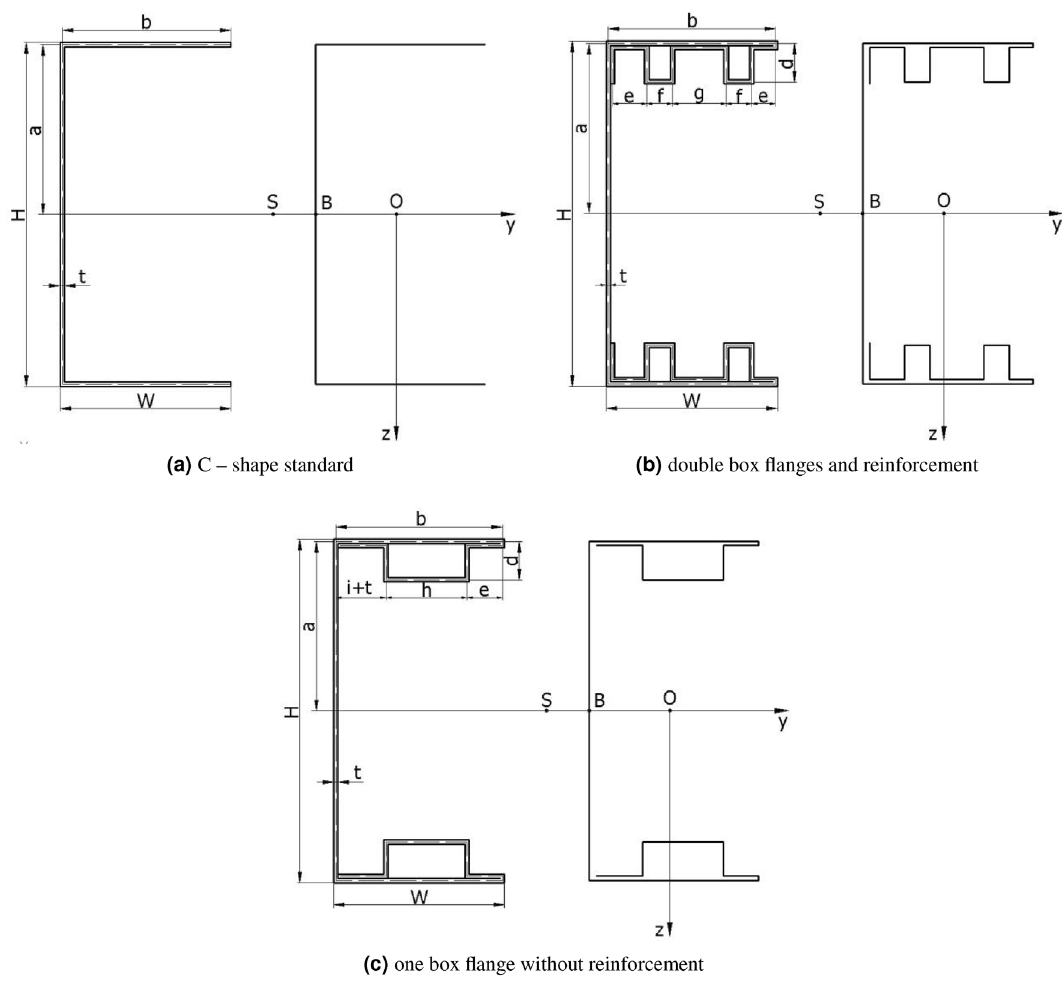
Figure 4. Beam cross section dimensions.